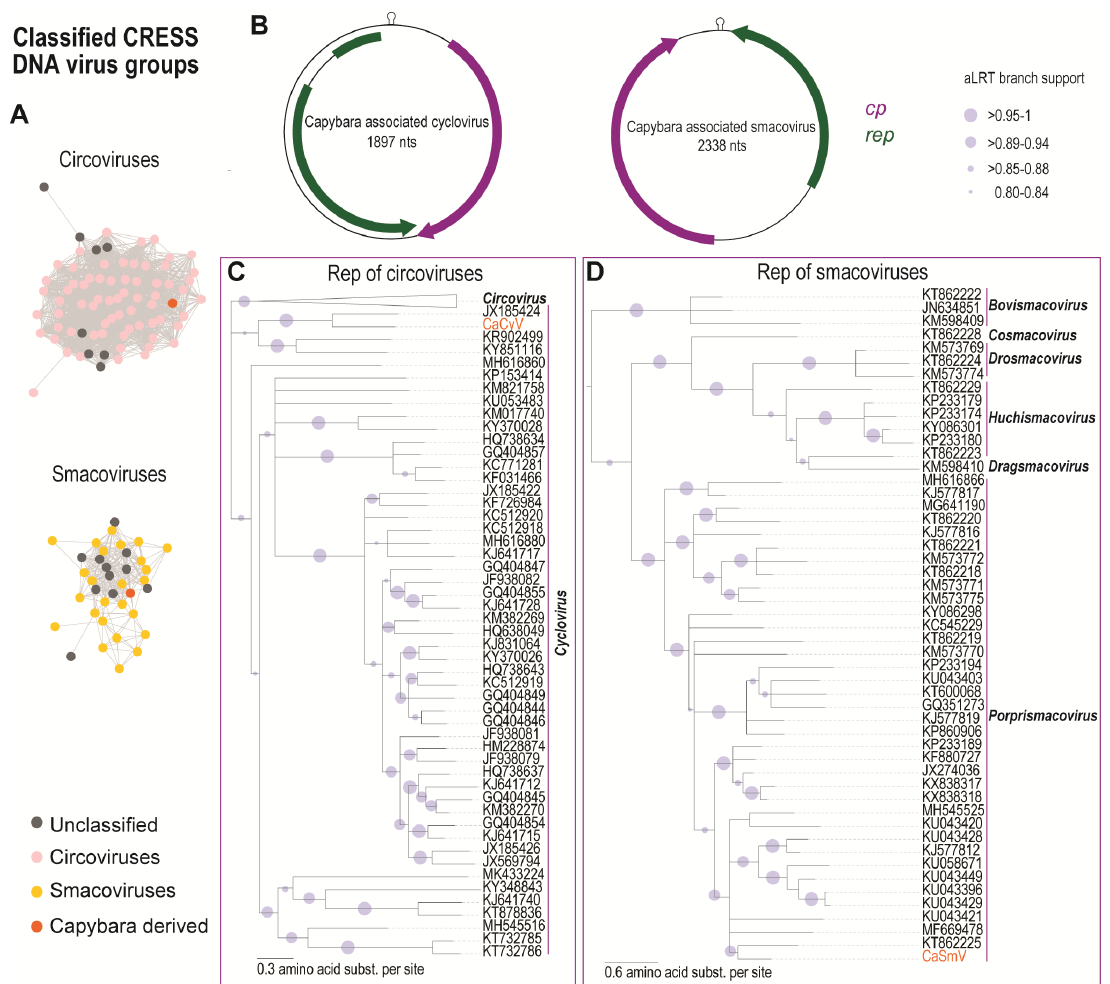
Table S2) [45]. Mapping of raw reads from each sample (Cap1 and Cap3) against the full-length genome of the CaCyV (Figure 1) revealed that the cyclovirus is common to both samples. Viruses 2019 , 11 , x FOR PEER REVIEW